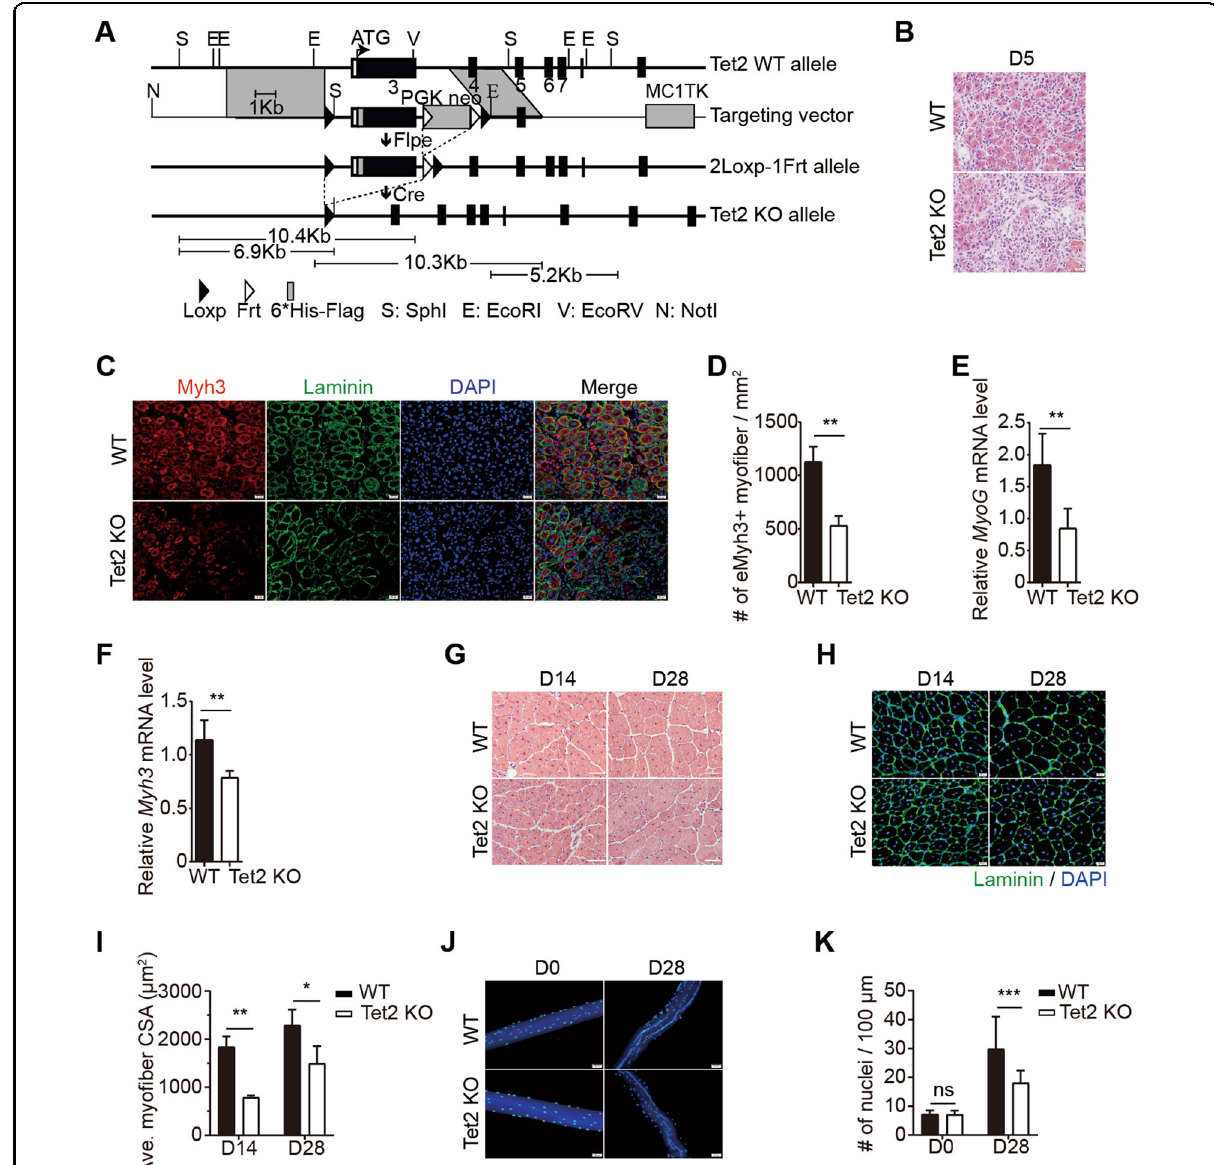
Fig. 1 Tet2 KO mice display muscle regeneration defects. A The scheme of Tet2 KO strategy. B Representative images of H&E staining of TA muscles isolated from WT or Tet2 KO mice on day 5 after injury. Scale bars, 20 μ m. C Immuno fl uorescence staining of Myh3 and Laminin of TA muscles isolated from WT or Tet2 KO mice on day 5 after injury. Scale bars, 20 μ m. D Quanti fi cation of the number of Myh3 + myo fi ber per mm 2 on day 5 after injury ( n = 3). E Relative mRNA expression level of MyoG in TA muscles isolated from WT or Tet2 KO mice on day 3 after injury ( n = 5). F Relative mRNA expression level of Myh3 on day 5 after injury ( n = 5). G Representative images of H&E staining of TA muscles isolated from WT or Tet2 KO mice on day 14 or day 28 after injury. Scale bars, 50 μ m. H Immuno fl uorescence staining of Laminin of TA muscles isolated from WT or Tet2 KO mice on day 14 or day 28 after injury. Scale bars, 20 µm. I Quanti fi cation of the cross-section area (CSA) from regenerated myo fi bers on day 14 and 28 after injury ( n = 3). J Representative images of myonuclear staining of myo fi bers isolated from WT or Tet2 KO TA muscle before injury or on day 28 after injury. Scale bars, 50 µm. K Quanti fi cation of myonuclei number per 100 µm in single myo fi ber on day 28 after injury ( n = 3). * p < 0.05, ** p < 0.01, *** p <